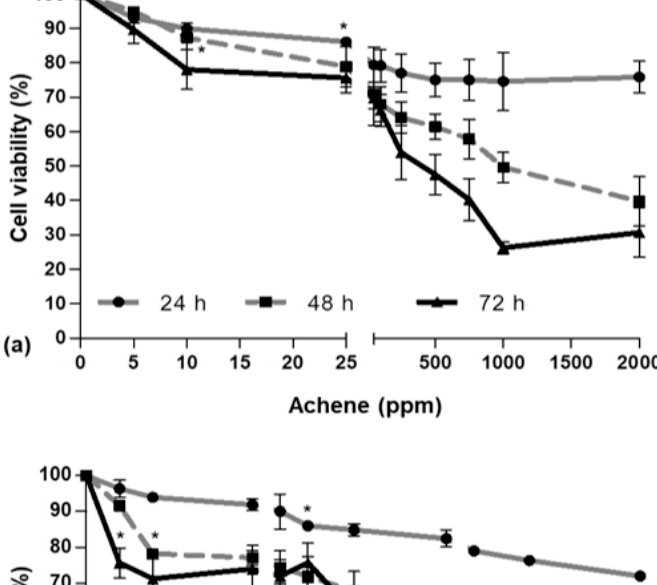
Figure 2. Viability of HepG2 determined by the MTT assay after incubation with different concentrations of ( a ) raw fruit; ( b ) fruit after gastric digestion; ( c ) fruit after intestinal digestion. Values are expressed as the mean ± SD of three independent experiments ( n = 3). * Indicates the concentrations from which significant differences ( p < 0.05) were observed compared to the control.